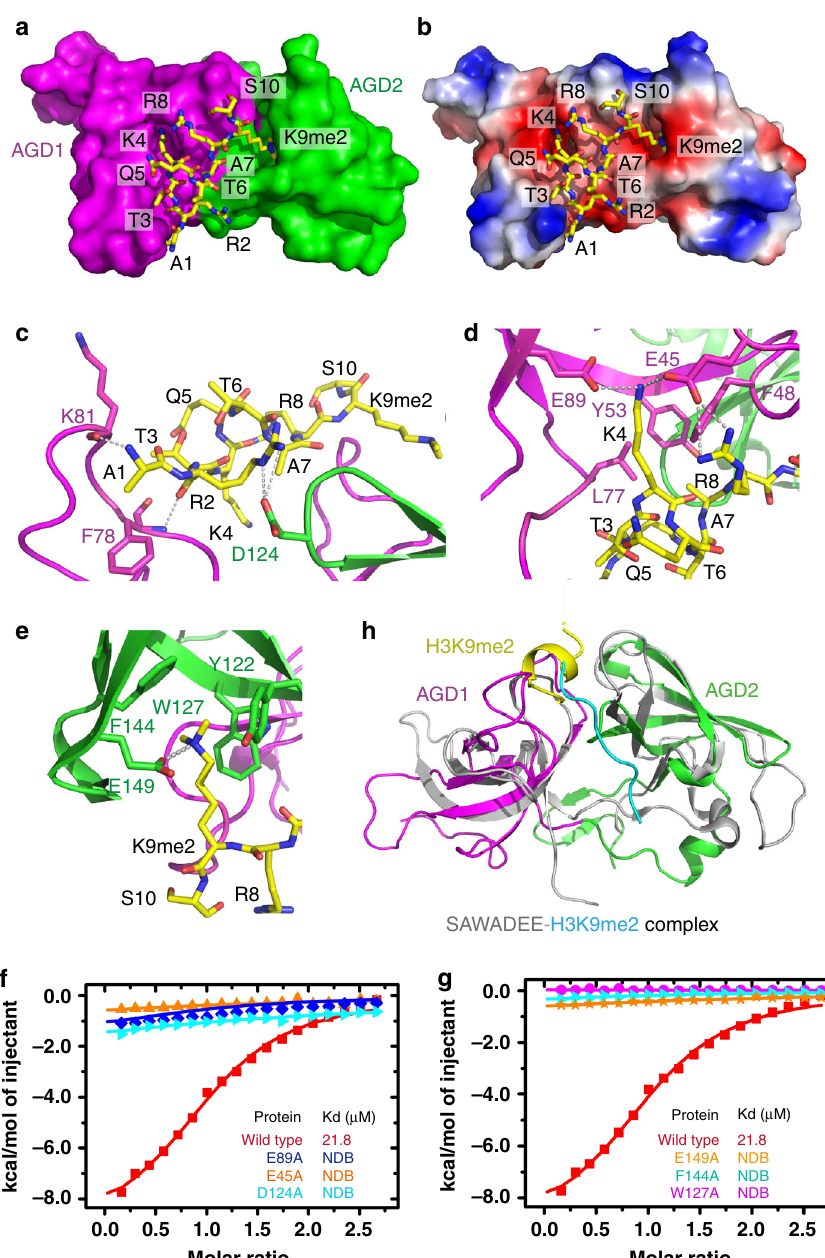
Fig. 2 Interactions between the H3K9me2 peptide and RsAGDP1 AGD12. a A surface view of the RsAGDP1 AGD12 with AGD1 and AGD2 colored in magenta and green, respectively. The H3K9me2 peptide is shown in stick representation. The side chains of H3K4me0 and H3K9me2 insert into two adjacent surface pockets on AGD1 and AGD2, respectively. b An electrostatics surface view of the RsAGDP1 AGD12 with the H3K9me2 peptide in stick representation. The peptide binds at a large negatively charged surface with H3K4me0 and H3K9me2 inserting into two negatively charged surface pockets, respectively. c - e The detailed recognition of H3A1 and H3R2 ( c ), H3K4, H3A7, and H3R8 ( d ), and H3K9me2 ( e ). The interacting residues and the hydrogen bonds are highlighted in stick and dashed silver lines, respectively. f - g The ITC-binding curves between H3K9me2 and RsAGDP1 AGD12 mutations disrupting the H3R2, H3K4, and H3R8 ( f ) or the H3K9me2 ( g ) binding residues show that the mutations of critical residues signi fi cantly impair the binding between AGD12 and H3K9me2. h A superimposition of RsAGDP1 AGD12-H3K9me2 complex (in color) and SHH1 SAWADEE-H3K9me2 complex (in silver, PDB code: 4IUT). The H3K9me2 peptide from the SHH1 SAWADEE complex is colored in cyan. The AGDP1 AGD12 and SHH1 SAWADEE generally adopt a similar folding topology with their binding H3K9me2 peptides locating at the shorter and longer edge of the two AGD/tudor domain interface, (Fig. 3b). The relative preferences of H3K9me3 and H3K9me1 by charge of the H3K9me2-binding pockets, leading to different sub- different tandem AGD cassettes are different, too. A possible level preferences. These sub-level preferences may participate in reason could be that some minor differences outside the the fi ne tuning functions of different tandem AGD cassettes and H3K9me2-binding pocket may slightly change the shape and provide a plausible additional layer of regulation.